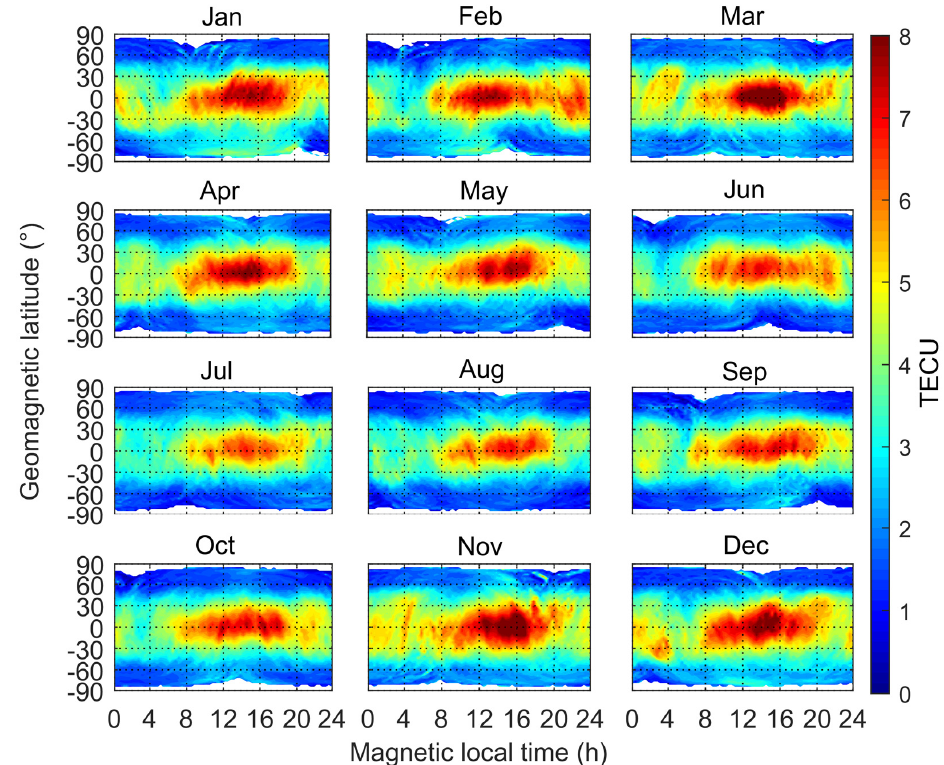
Figure 5. Monthly variation of plasmaspheric TEC in 2008.